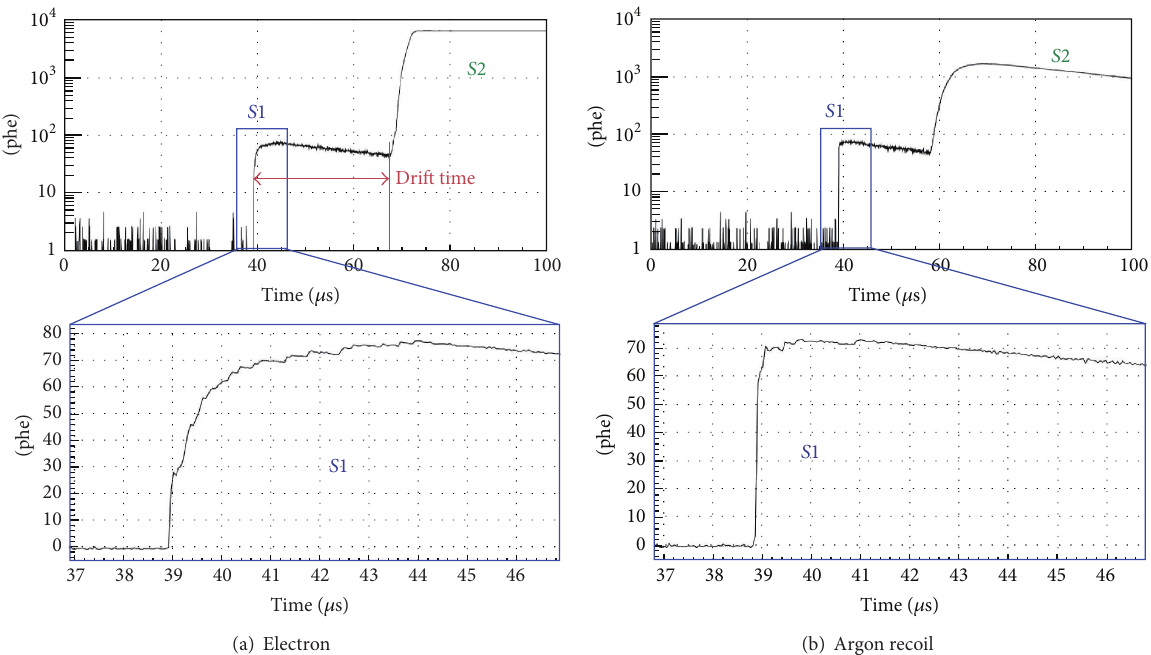
Figure2:Exampleofcollectedintegratedsignals,duetoelectrons(a)andnuclearrecoils(b).Thedifferenceinthemagnitudeofthesecondary signal 𝑠2 and in the rise time of the primary pulse (related to the fraction of fast light component 𝑠𝑓 ) is clearly visible for the two classes of